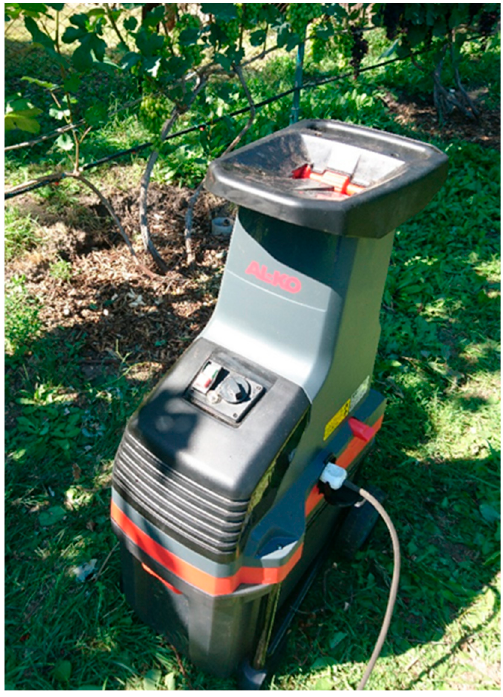
Figure 5. Branch chopper AL-KO LH 2810 Easy Crush (middle class).